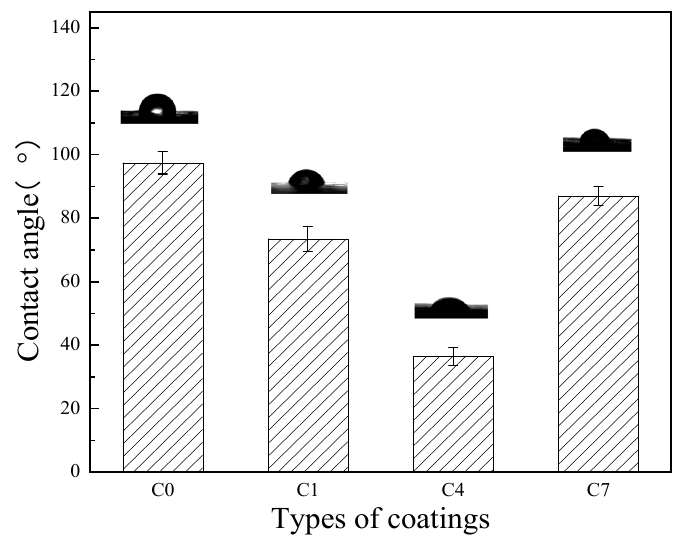
Figure 3. Contact angle of the coatings with and without modi fi cations.